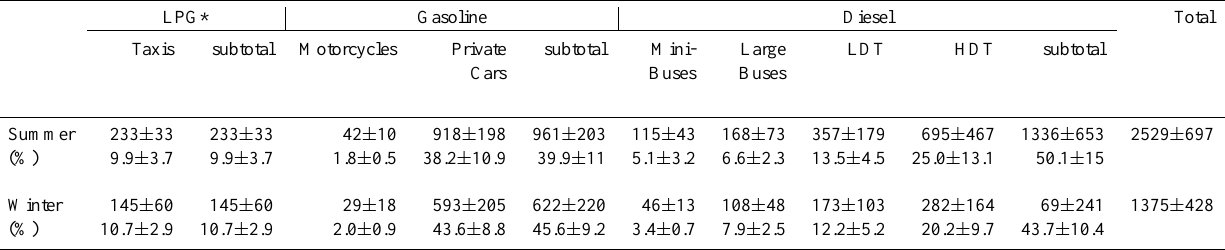
Table 1. The 1-hr average traffic composition of Shing Mun Tunnel in summer and winter in 2003. LPG* Gasoline Diesel Total Taxis subtotal Motorcycles Private subtotal Mini- Large LDT HDT subtotal Cars Buses Buses